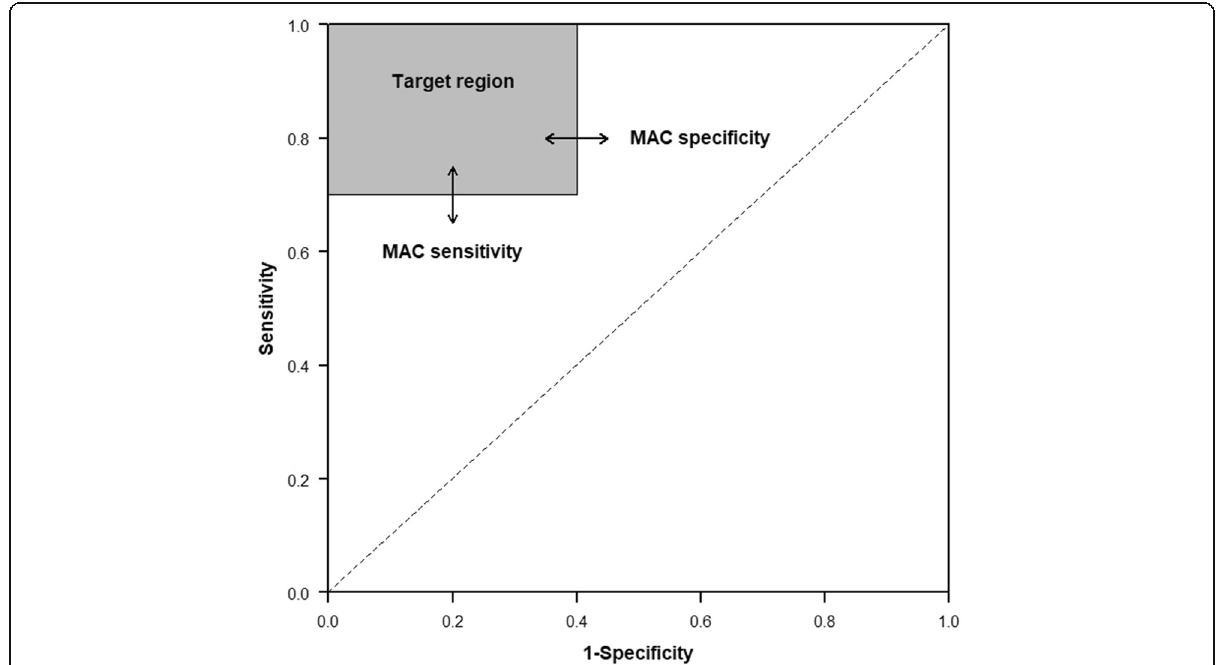
Fig. 2 Receiver operating characteristic (ROC) space with “ target region ” based on minimally acceptable criteria for accuracy. ROC space has two dimensions: sensitivity ( y -axis) and 1-specificity ( x -axis). When the sum of sensitivity and specificity is ≥ 1.0, the test ’ s accuracy will be a point somewhere in the upper left triangle. The “ target region ” of a diagnostic accuracy study will always touch the upper left corner of ROC space, which is the point for perfect tests, where both sensitivity and specificity are 1.0. From there, the rectangle extends down, to MAC for sensitivity, and extend to the right, towards MAC for specificity. The gray square represents the target region of a diagnostic accuracy study with a MAC (sensitivity) of 0.70, and a MAC (specificity) of 0.60. MAC, minimally acceptable